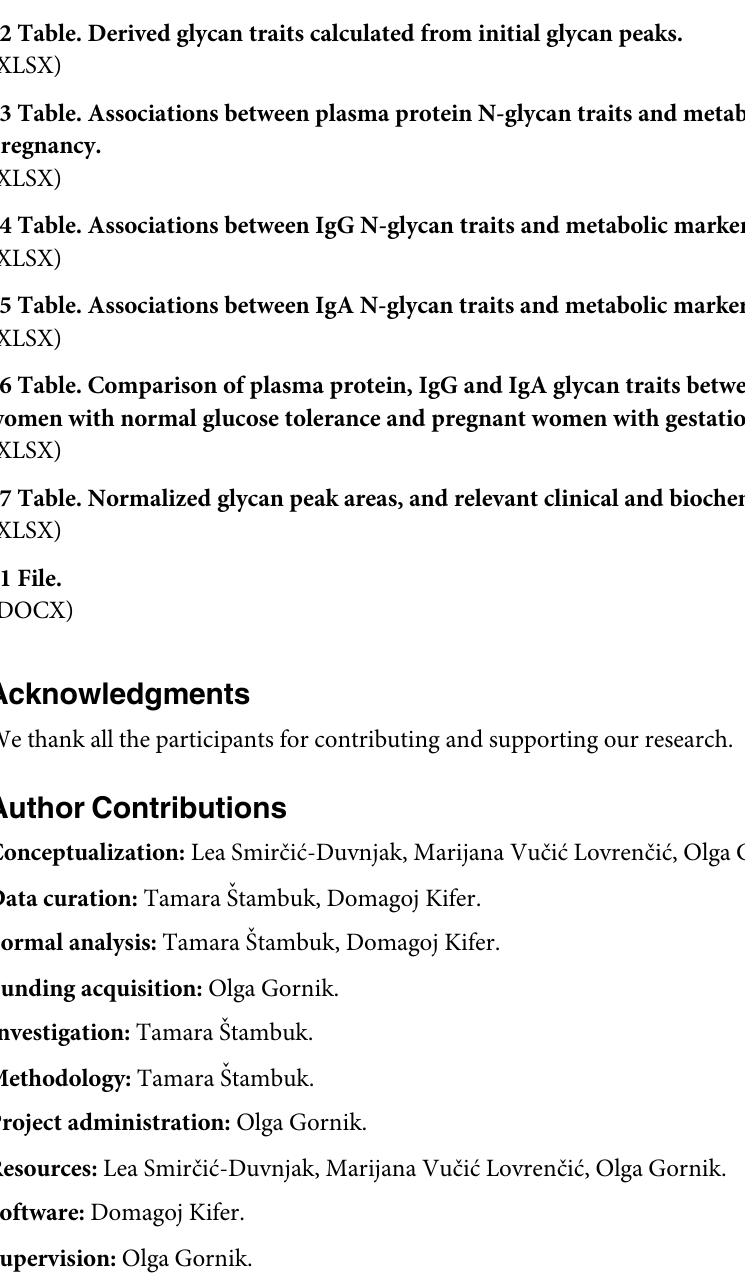
S1 Table. Detailed description of glycan structures corresponding to every individual plasma protein, IgG and IgA glycan peak (GP). S2 Table. Derived glycan traits calculated from initial glycan peaks. S3 Table. Associations between plasma protein N-glycan traits and metabolic markers in pregnancy. S4 Table. Associations between IgG N-glycan traits and metabolic markers in pregnancy. S5 Table. Associations between IgA N-glycan traits and metabolic markers in pregnancy. S6 Table. Comparison of plasma protein, IgG and IgA glycan traits between pregnant women with normal glucose tolerance and pregnant women with gestational diabetes. S7 Table. Normalized glycan peak areas, and relevant clinical and biochemical data. (XLSX) S1